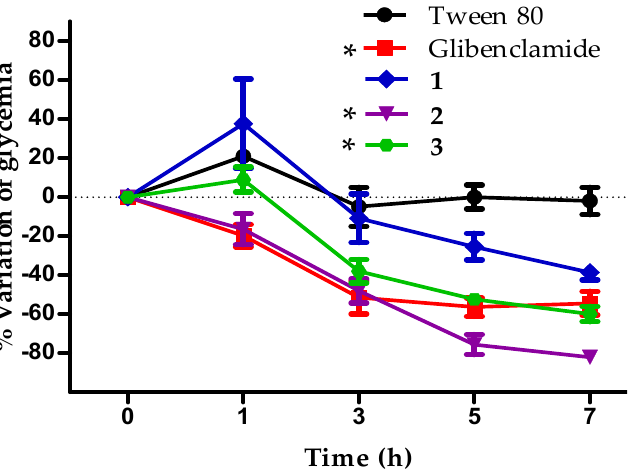
Figure 6. Effect of a single dose (100 mg/kg) of compounds 1 – 3 and glibenclamide (5 mg/kg) in STZ-NA induced diabetes mice model (intragastric, n = 6). * p < 0.05 versus Tween 80 (10%) group.